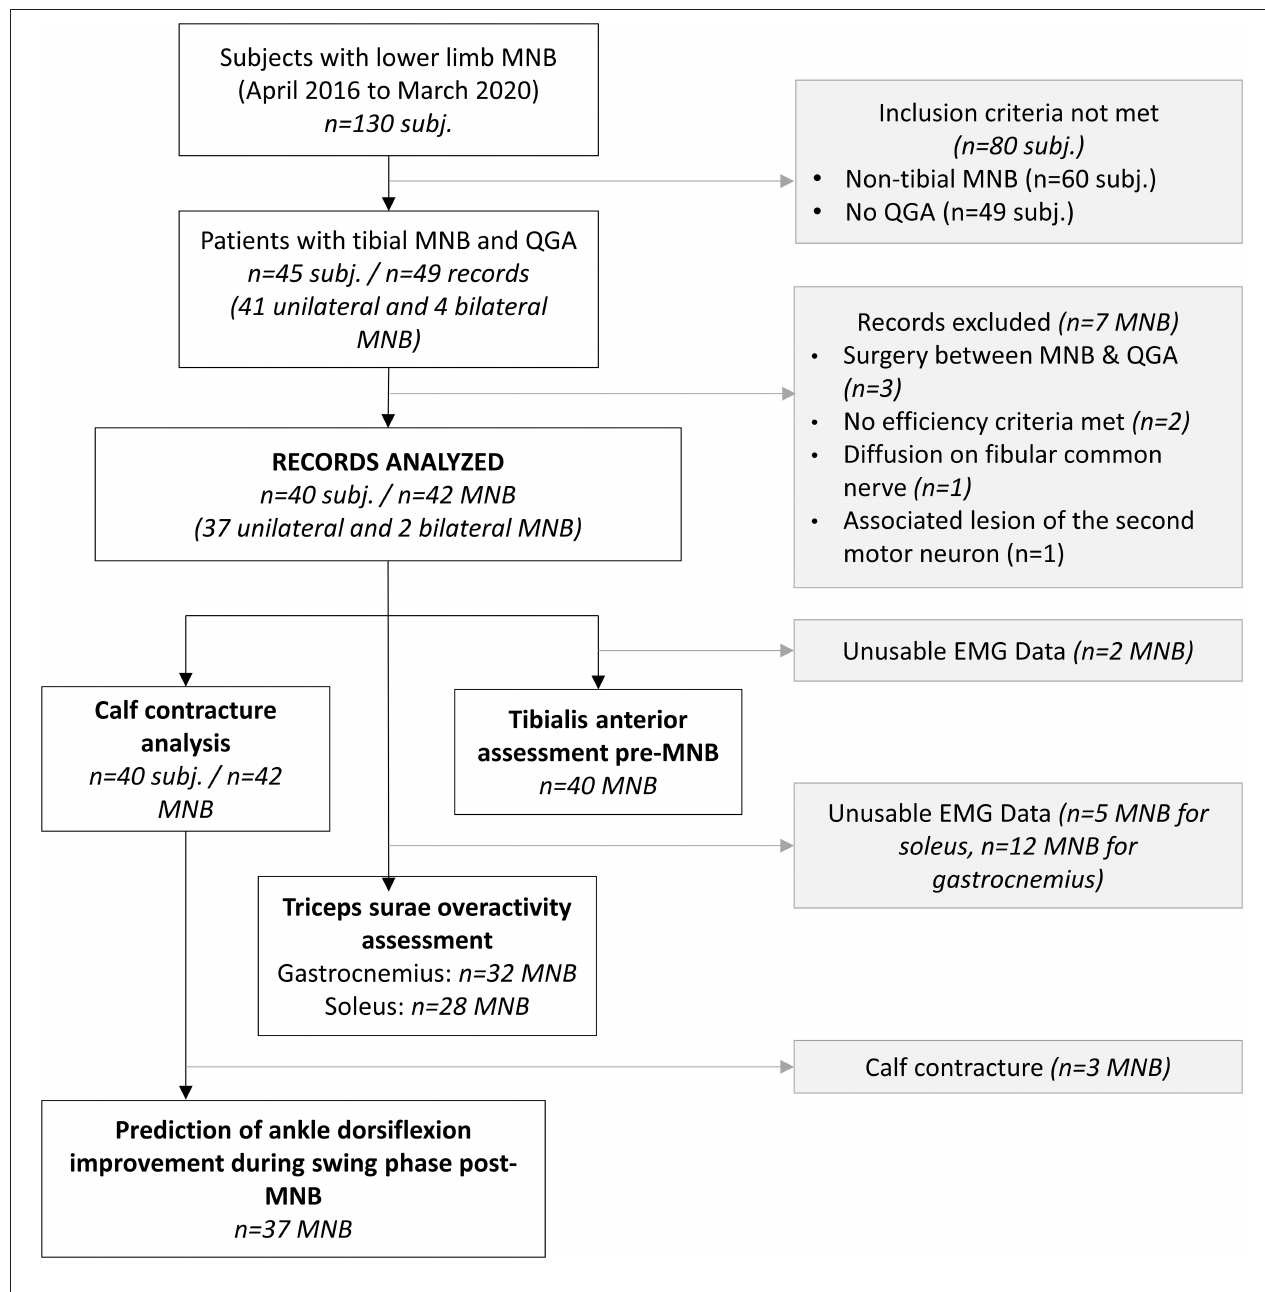
FIGURE 3 | Flowchart (3D-I3D-IGA, instrumented 3D gait analysis; MNB, motor nerve block; subj, subject).